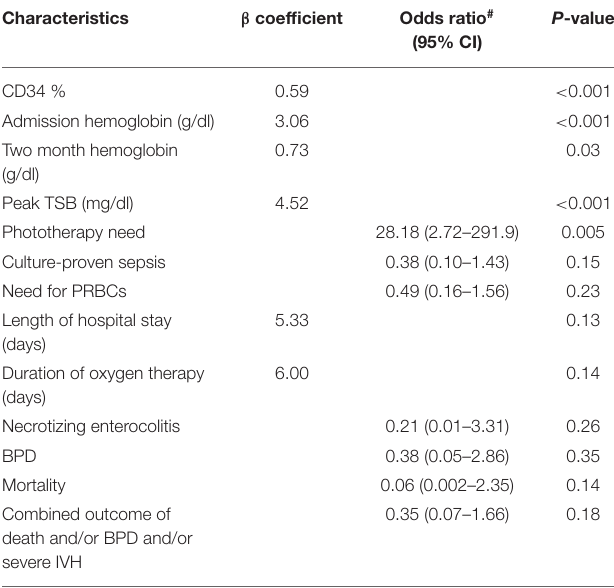
TABLE 4 | Multiple linear and binary logistic regression analysis of umbilical cord milking vs. immediate cord clamping regarding outcomes in preterm infants with ante-natal evidence of placental